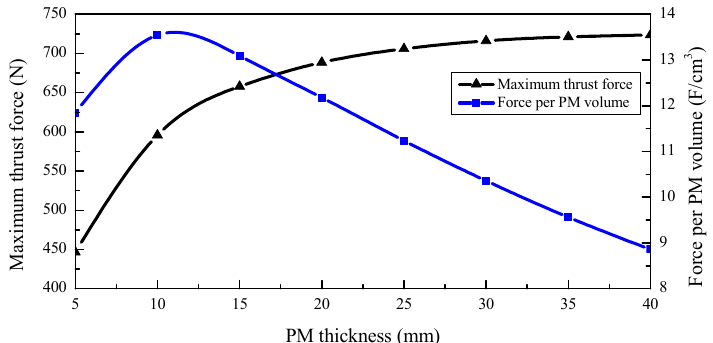
Figure 12. Variation in the maximum thrust force and force per PM volume with different PM thicknesses.